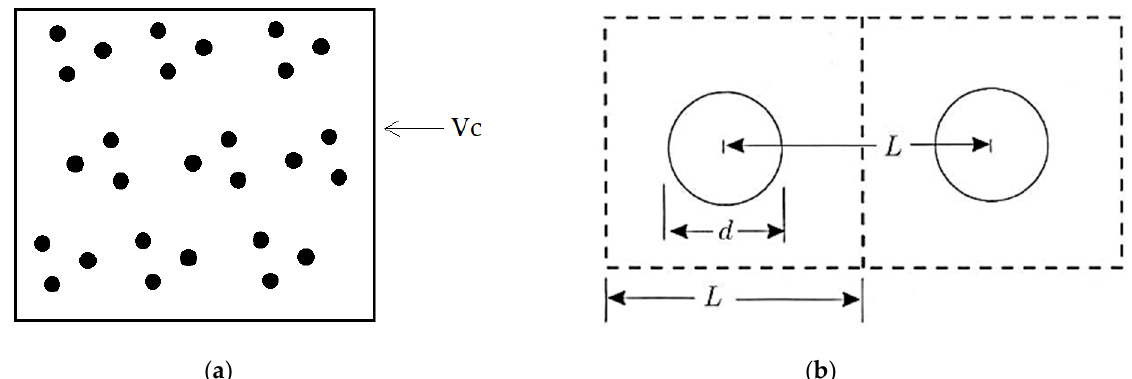
Figure 6. ( a ) Solid particles dispersed in a control volume V c ( b ) Concept of the entity spacing L/d. The diameter of the sand particles used for the experiment had a diameter between 0.20 mm and 0.25 mm. Thus, a mean diameter d exp = 0.225 mm was assumed for